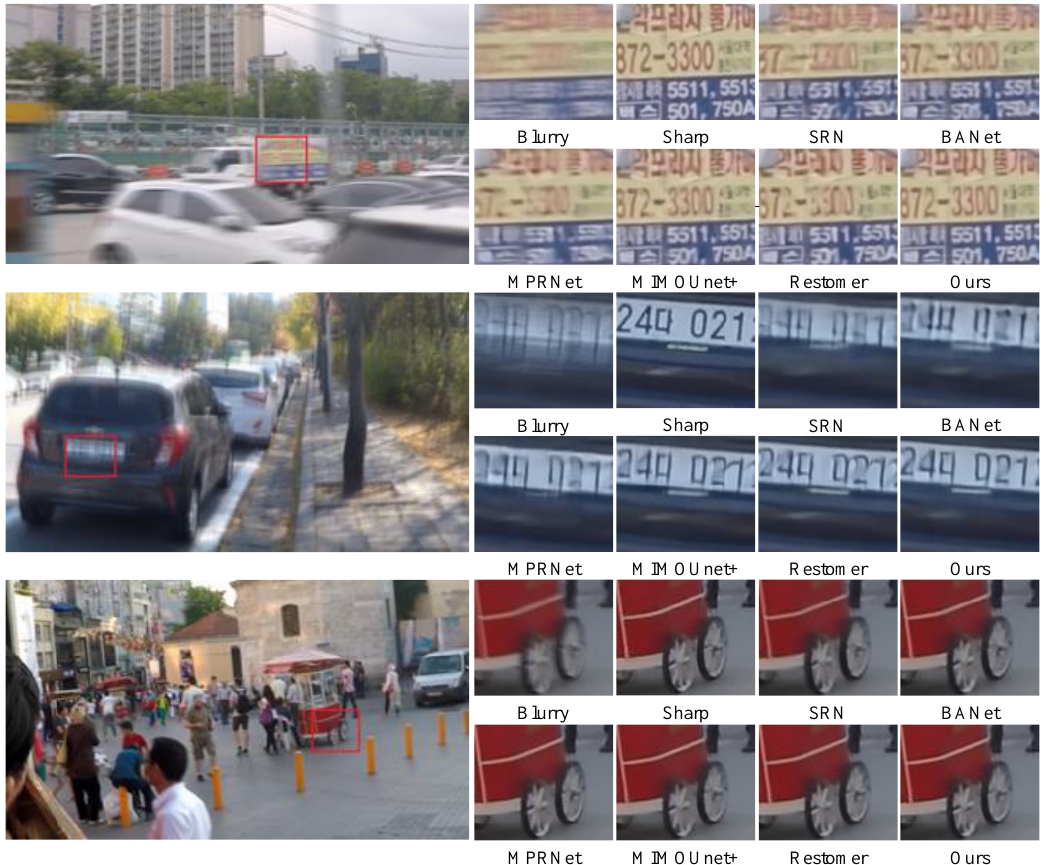
Figure 7. Some visual comparisons on the GoPro dataset. From top left to bottom right: blurry im- ages, the ground truth images, the restoration of SRN [12], BANet [17], MPRNet [2], MIMO-Unet+ [8], Restomer [18], and our model.